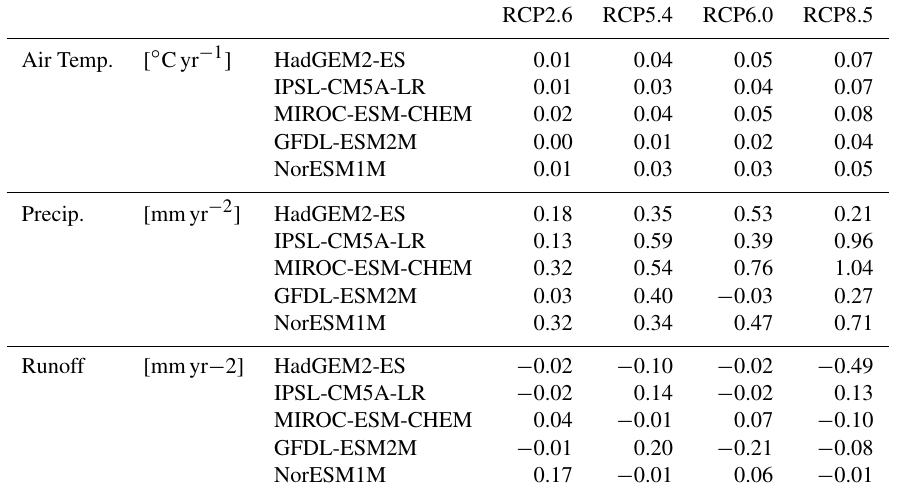
Table 2. Linear regression slope of the projected air temperature, precipitation and WBMplus simulated runoff for the 2006–2099